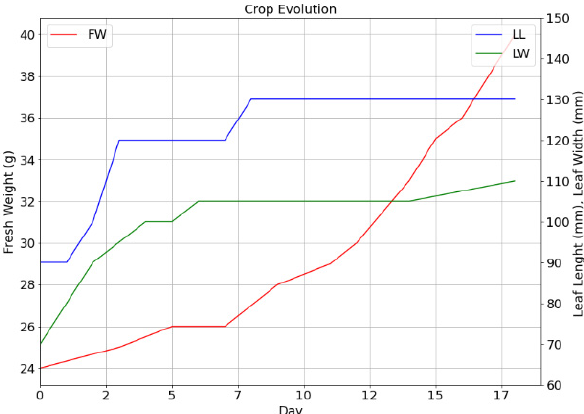
Figure 16. Yield evolution regarding fresh weight, leaf length and width in the test plant.